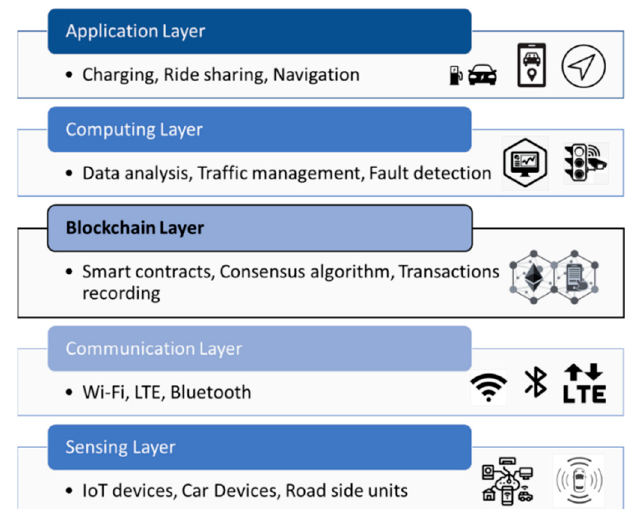
Figure 1. Blockchain and IoV architecture.